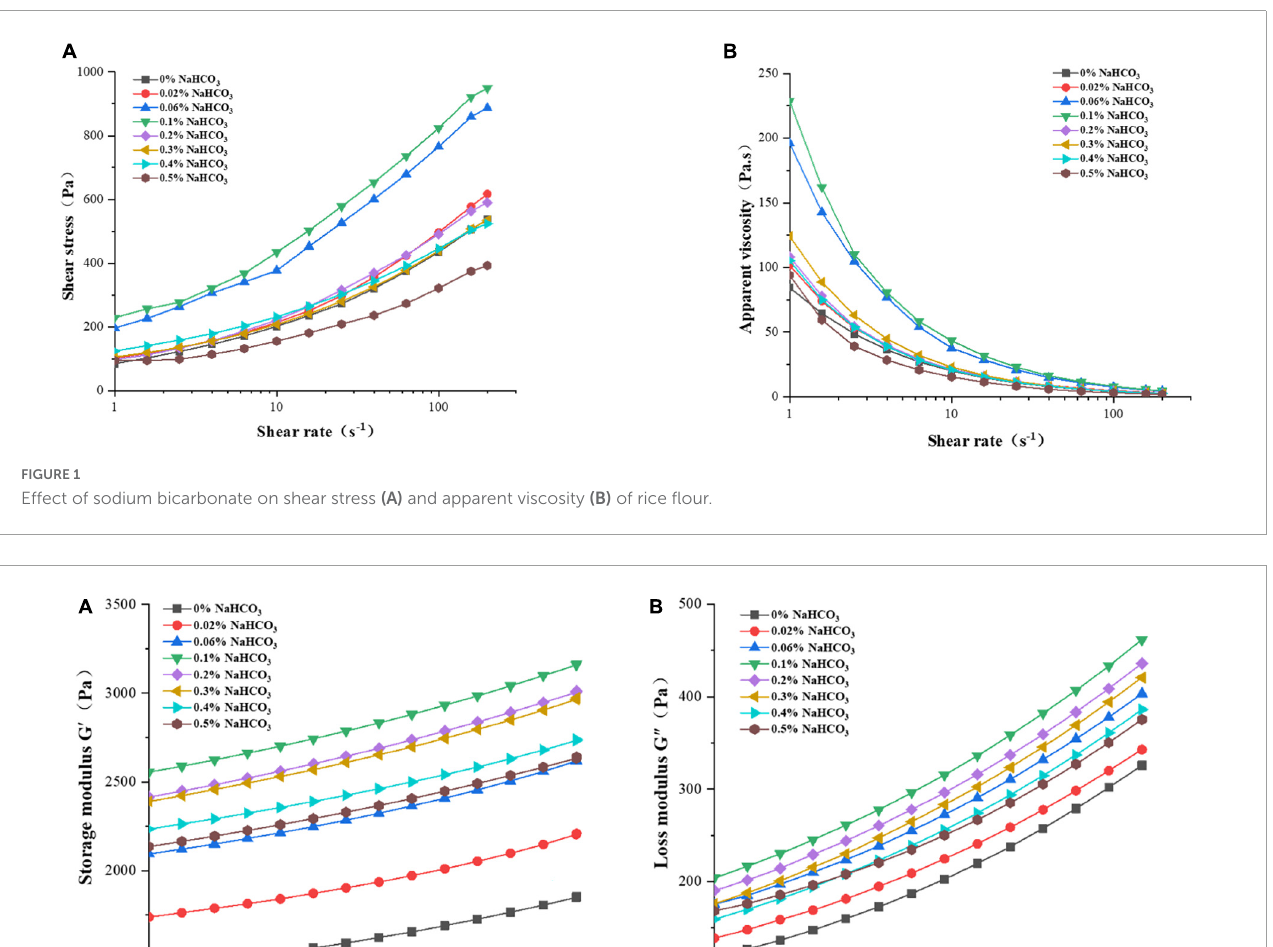
Figure 1A , as the addition of sodium bicarbonate was from 0 to 0.1%, the shear stress of rice flour increased; and it decreased at 0.1 to 0.5